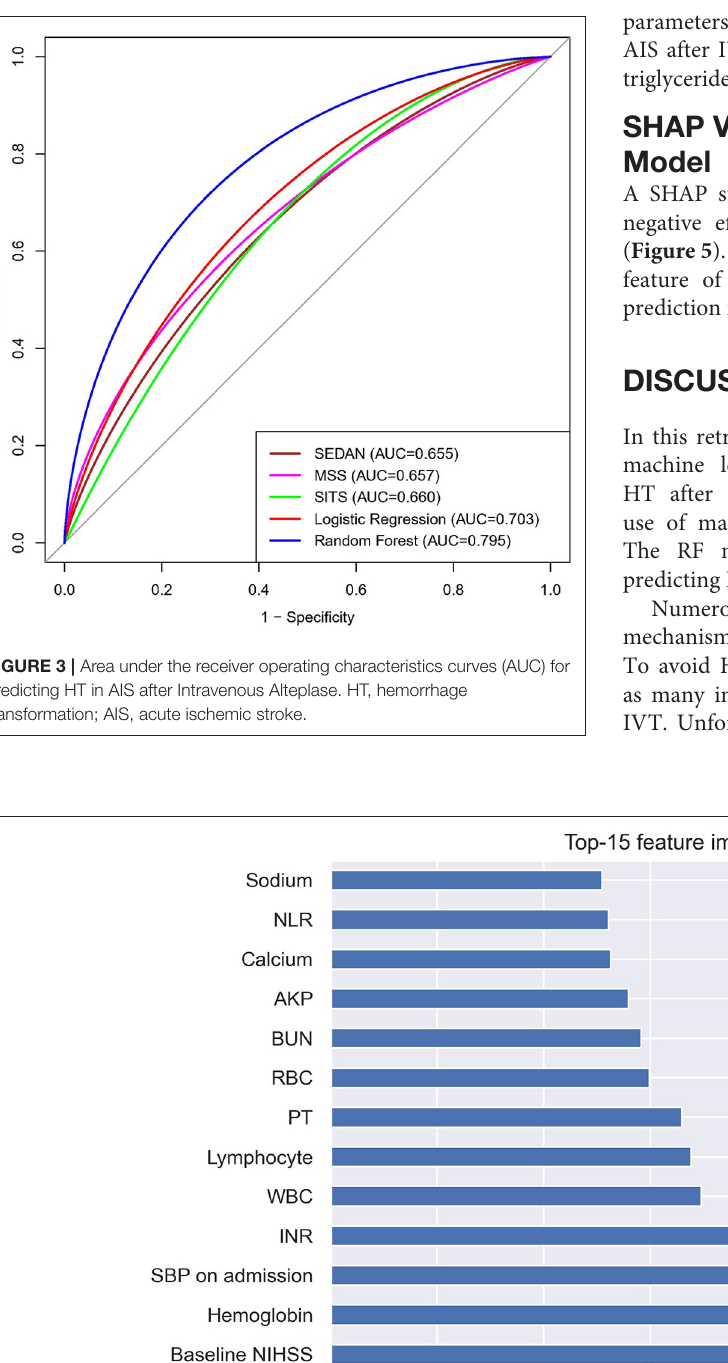
Frontiers in Neurology |